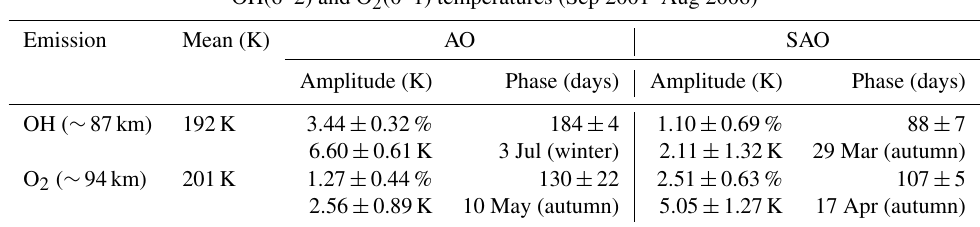
Table 1. Results of the harmonic fits to the spectrometer OH(6–2) and O 2 (0–1) rotational temperature time series for the entire observational period (September 2001 until August 2006). Phase indicates the first maximum after 1 January. Amplitudes of the AO and SAO are given both relative to the mean temperature and in